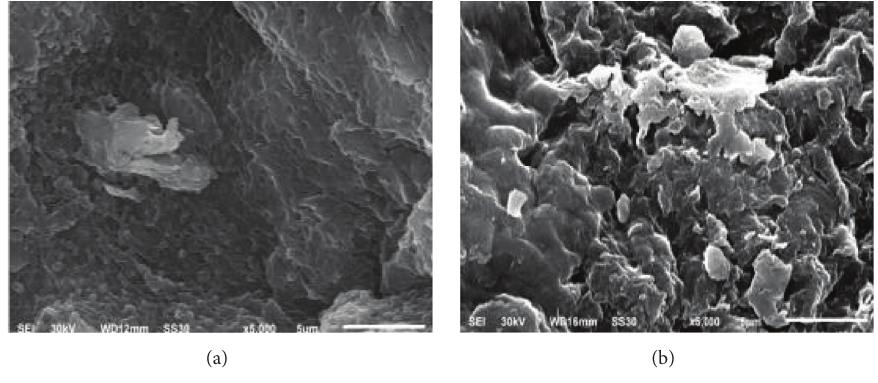
Figure 2: The SEM of rectorite particles.